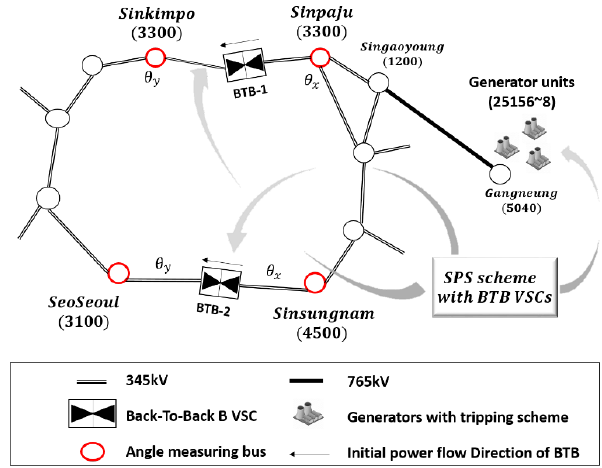
Figure 7. Simulation environment in Korea power system. T able 1. System parameter of BTB VSC.